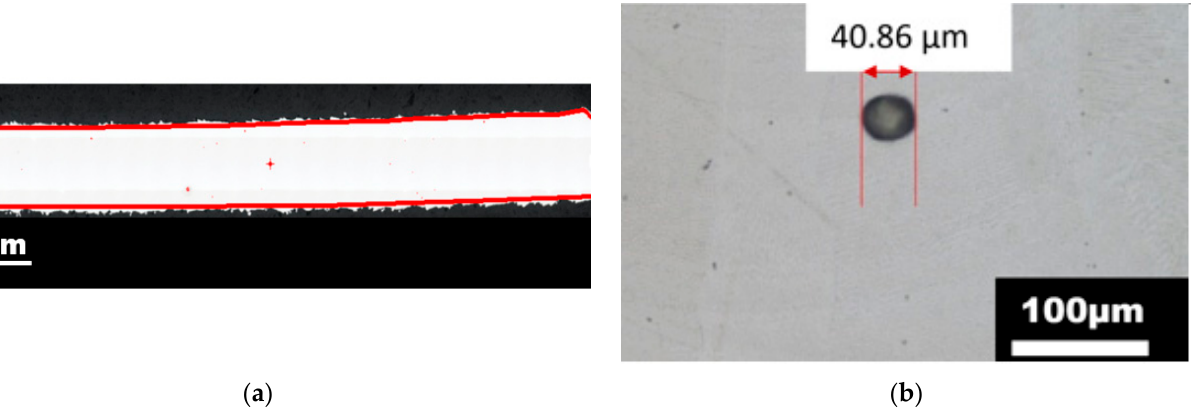
Figure 7. ( a ) The evaluation area of porosity analysis—ZY plane (parallel to build direction), ( b ) Results of porosity analysis—pore of the largest diameter (40.86 µm) found in the structure observed using light microscopy.